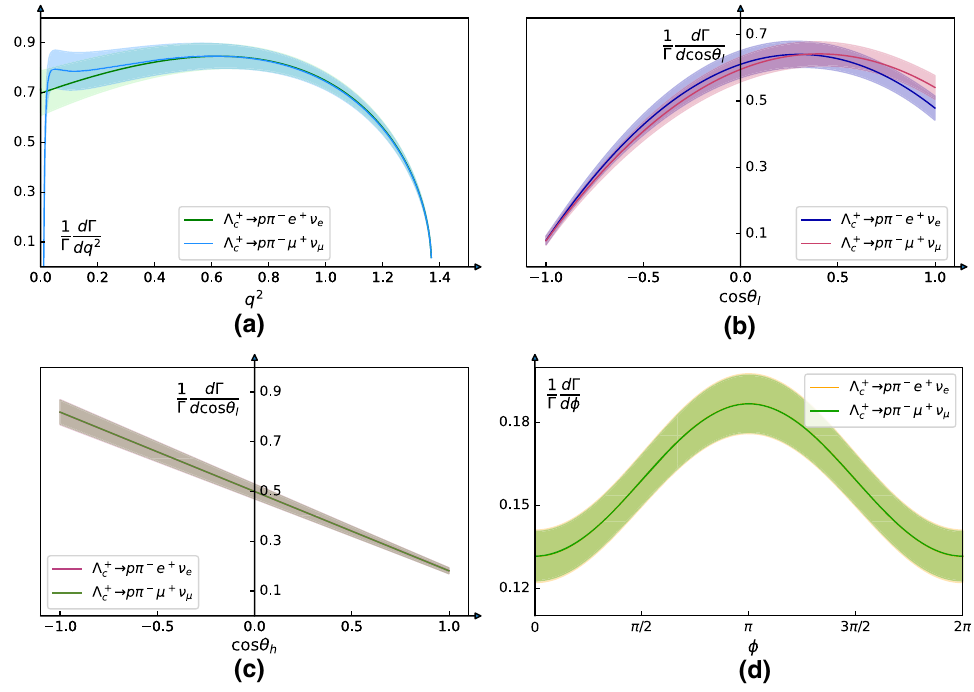
Fig. 3 Differential decay width for (cid:4) + c → p π − (cid:2) + ν (cid:2) as a function of q 2 ( a ), cos θ l ( b ), cos θ h c , and φ d , respectively. It should be noted that in b and c , the errors increase with θ l from -1 to 1 and θ h from 1 to − 1, as a result of the remarkable uncertainties of form factors at the small- q 2 region